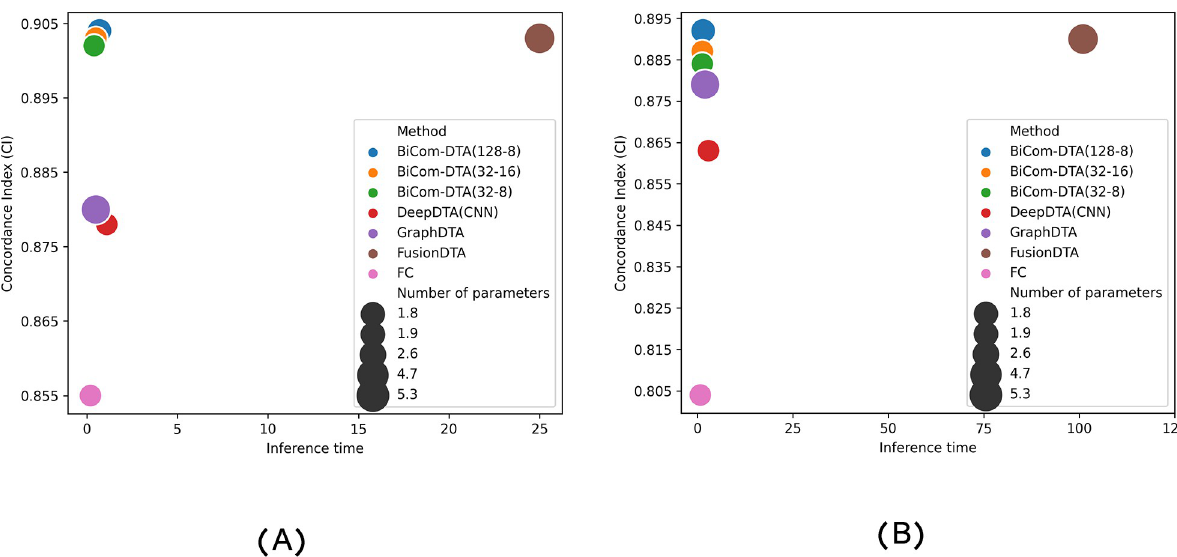
Fig 8. Accuracy vs. inference time on GPUs, and the number of parameters for BiComp-DTA and alternative methods. (A) Inference time for Davis dataset, and (B) Inference time for Kiba dataset.